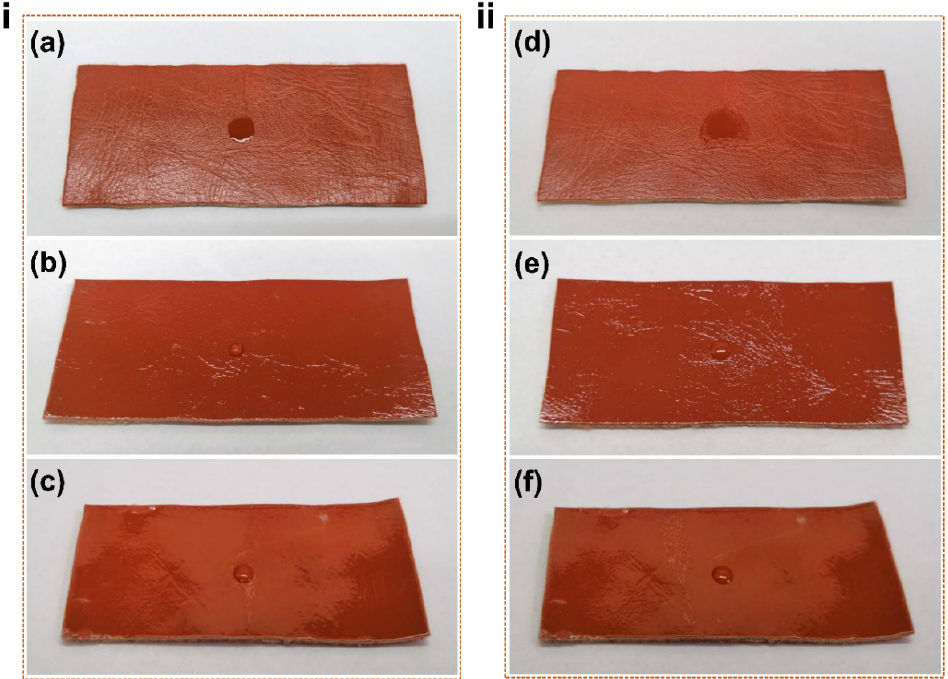
Figure 6. ( i ) Waterproofing grade test with 40/60 ( v / v ) of water/isopropyl alcohol on uncoated leather ( a ), leather coated with FPU waterproofing agent ( b ), and commercial C8